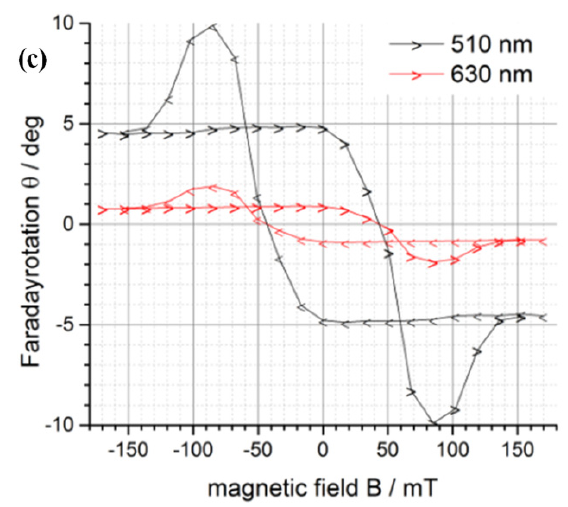
Figure 5. ( a ) An unconventional magnetic hysteresis loop measured in an all-garnet multilayer structure (SD2 with 500 nm individual layer thicknesses, deposited onto a GGG substrate) with an external magnetic field applied in the direction perpendicular to the film plane. Faraday rotation angle of the structure (for plane-polarized 532 nm light) was traced in transmission mode at different magnetization states using Thorlabs PAX polarimeter system. ( b ) Magnetic hysteresis loop of a multilayer structure (SD2 with 500 nm individual layer thicknesses, deposited onto a glass substrate), re-measured in another sample on glass substrate at different wavelengths. The external magnetic field was again applied in the direction perpendicular to the film plane. Faraday rotation angles of the structure (for plane-polarized 510 nm and 630 nm light beams incident normally) were traced in transmission mode at different magnetization states using a custom-made, splitting-cube-based polarimetry system. ( c ) Magnetic hysteresis loop of an SD2 multilayer measured using a custom-made polarimetry system in a sample deposited onto a GGG